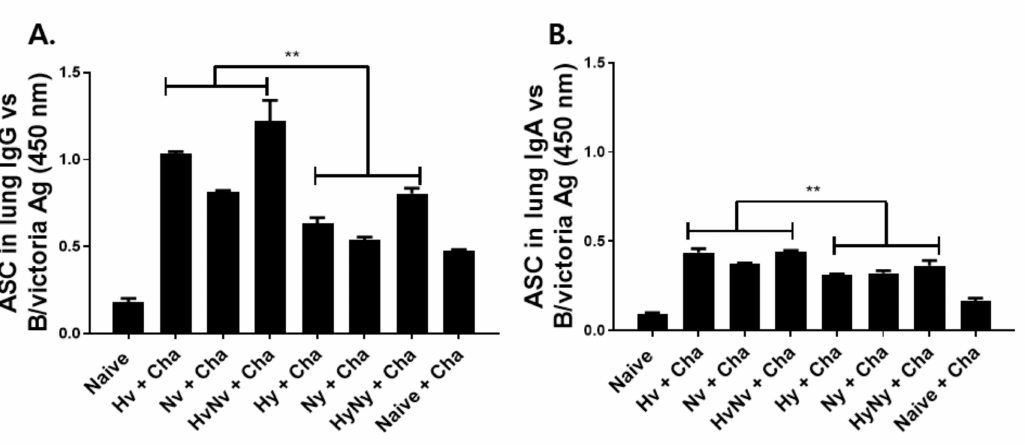
Figure 4. Antibody-secreting cell (ASC) responses in the lung. Immunized mice were challenge- infected with B/Colorado/06/2017 virus and at 4 dpi, lung cells were collected to measure ASC responses. ASC IgG ( A ) and IgA ( B ) antibody responses were evaluated by ELISA. Naïve+Cha refers to those naïve mice who were challenge infected with a lethal dose of influenza virus. Data are expressed as mean ± SD with asterisks denoting statistical significance between groups (** p <